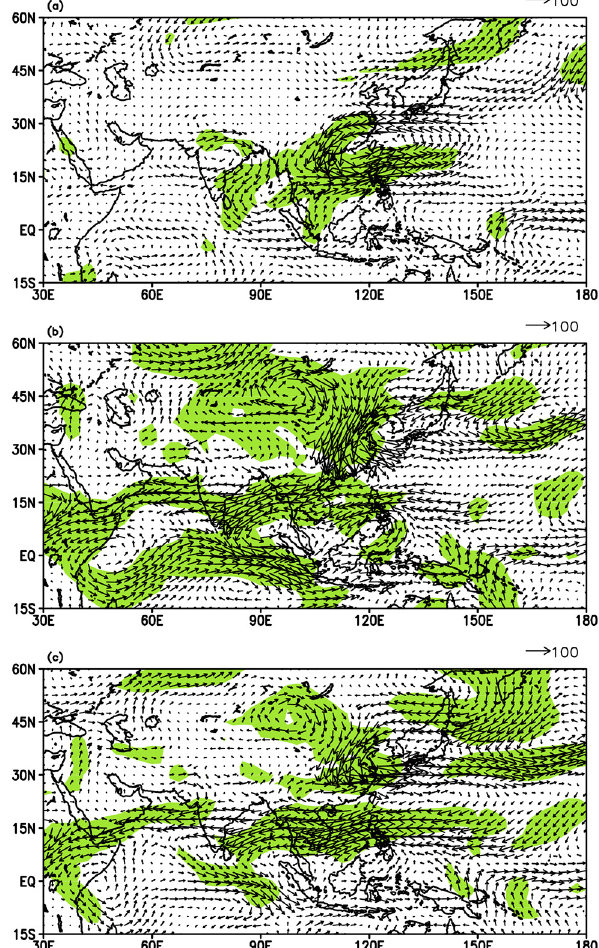
Figure 6. Same as Fig. 5 except for the 850hPa horizontal wind vectors (ms − 1 ). The wind vectors above the 95% confidence level are shaded.